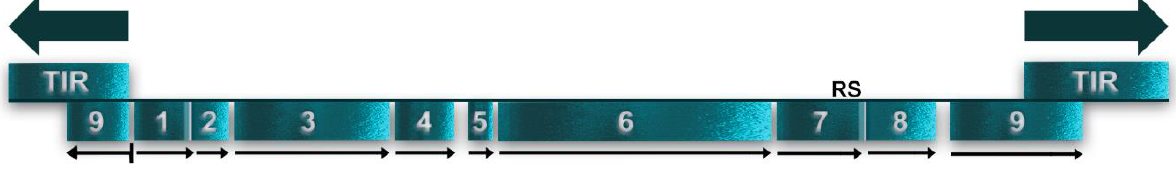
Figure 4. Representation of the recombination between the circular mtDNA (shown in magenta) and the linear mF plasmid (shown in teal) to produce the 77.3 kb linear mtDNA with 81 genes.